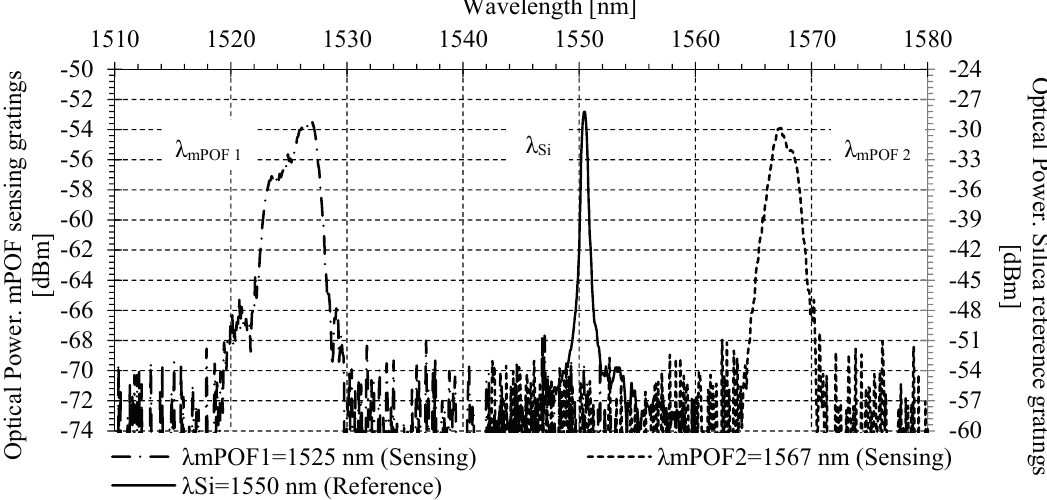
Figure 4. Optical spectrum in reflective operation of the mPOFBGs (sensing) and silica FBG (reference).